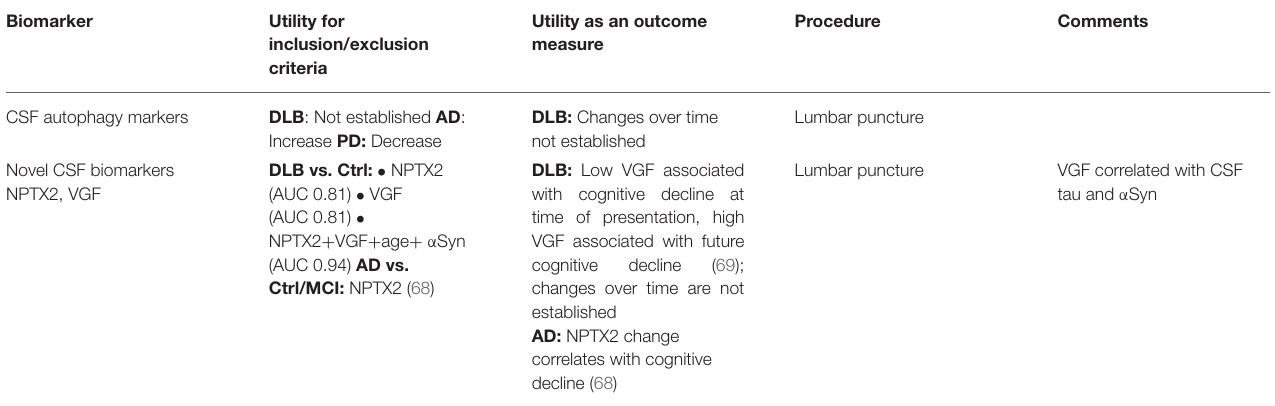
TABLE 3 | Fluid and tissue biomarkers for other disease mechanisms.